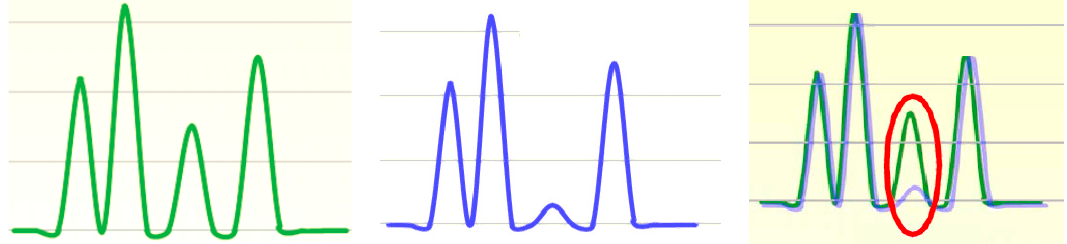
Figure 8. Mechanism of leak detection: theoretical spectrum ( left ), measured spectrum ( center ), and overlapping of both spectra to reveal leak ( right in red).